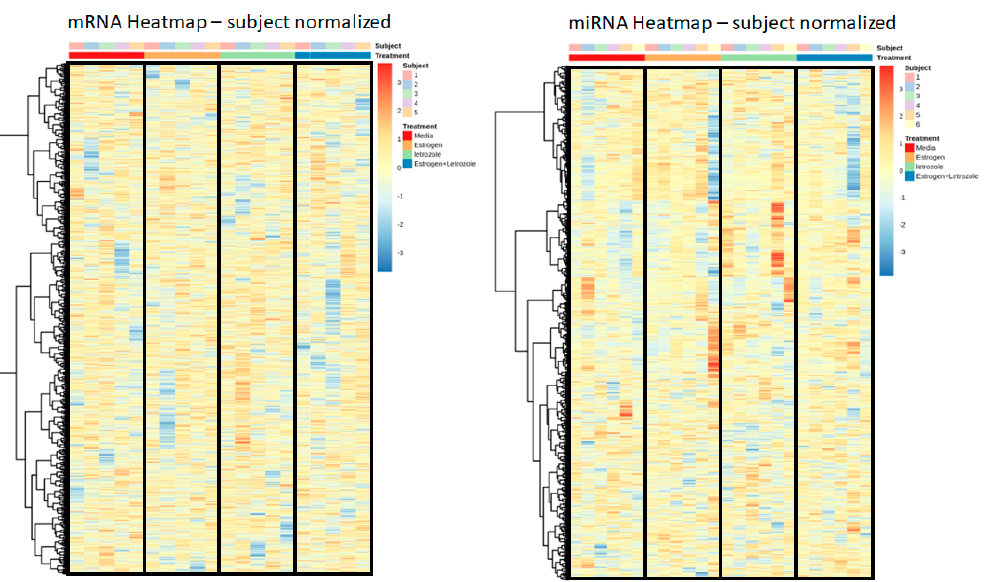
Figure 8. Genome-wide expression analysis of human PBMCs does not demonstrate an aromatase- inhibitor-mediated response. Freshly isolated human PBMCs were stimulated in vitro with estrogen, letrozole, or a combination of both for a comparison relative to untreated control samples. RNA sequencing was preformed to evaluate overall expression levels of mRNA and miRNA targets with each treatment sample. Data from each subject were normalized to control values, and relative expression levels are presented as heatmaps to evaluate genome-wide treatment effects on mRNA (left) and miRNA (right) transcripts.